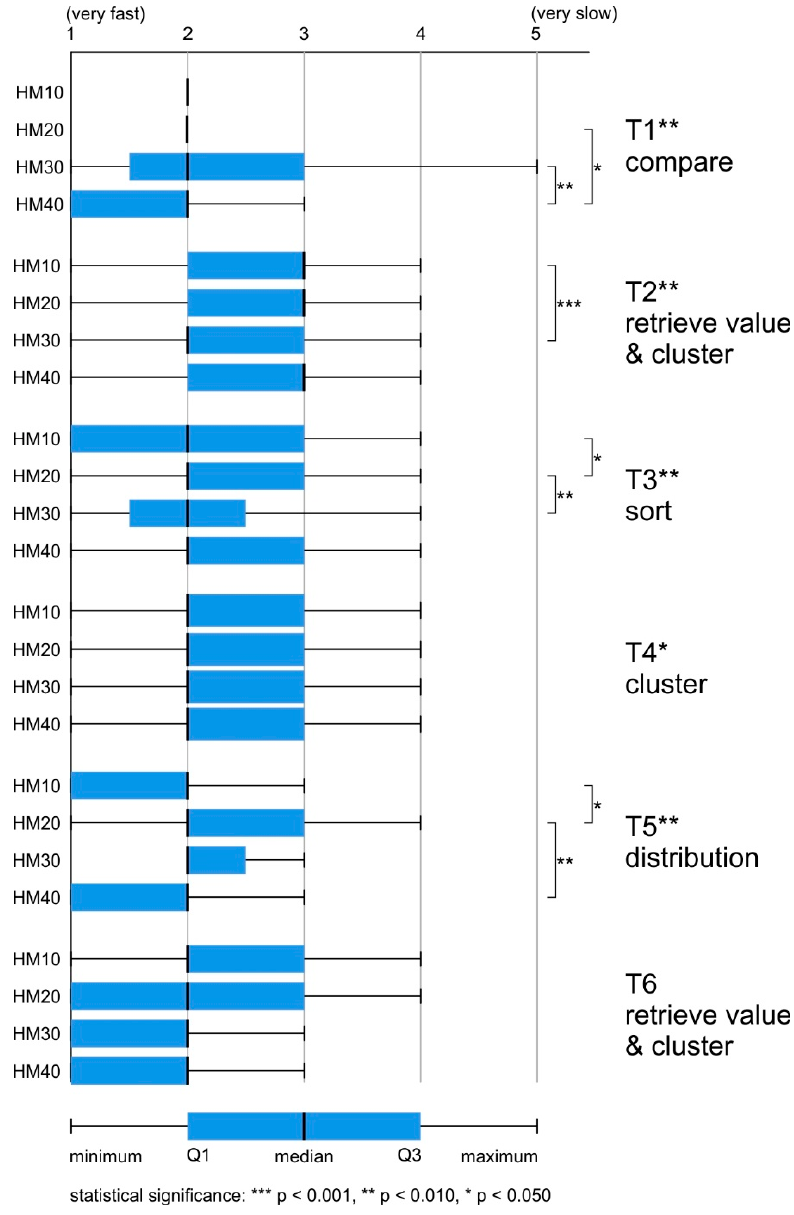
Figure 6. Differences in the response time assessment between participants using the four tested heat maps. Table 5. Inferential statistics between participants using the four tested heat maps.